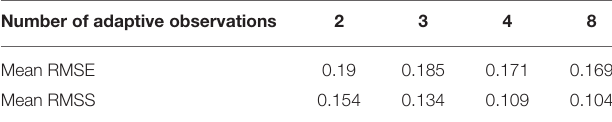
TABLE 3 | The mean RMSE and RMSS using PE with different number of adaptive